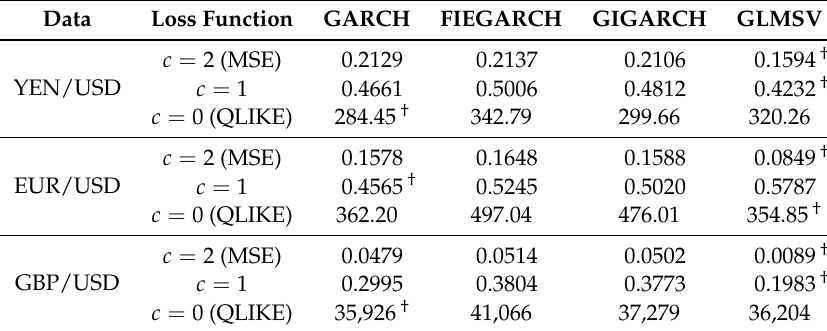
Table 7. Comparison of Volatility Forecasts.